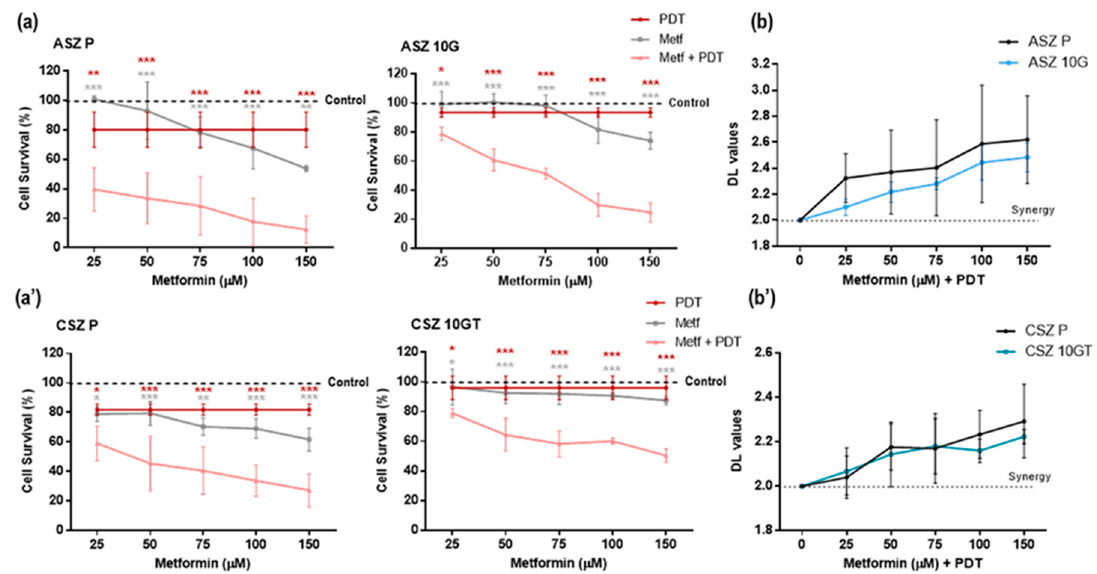
Figure 4. Combined treatment of Metf and MAL-PDT on cell viability: Cells were treated for 24 h with with Metf (25–150 µ M) and then subjected to MAL-PDT (0.2 mM MAL and 7.6 J / cm 2 in ASZ cells Metf (25–150 µM) and then subjected to MAL-PDT (0.2 mM MAL and 7.6 J/cm 2 in ASZ cells and 3.8 J/cm 2 in CSZ cells). Cell survival was evaluated by the MTT test. ( a ) The results obtained showed a